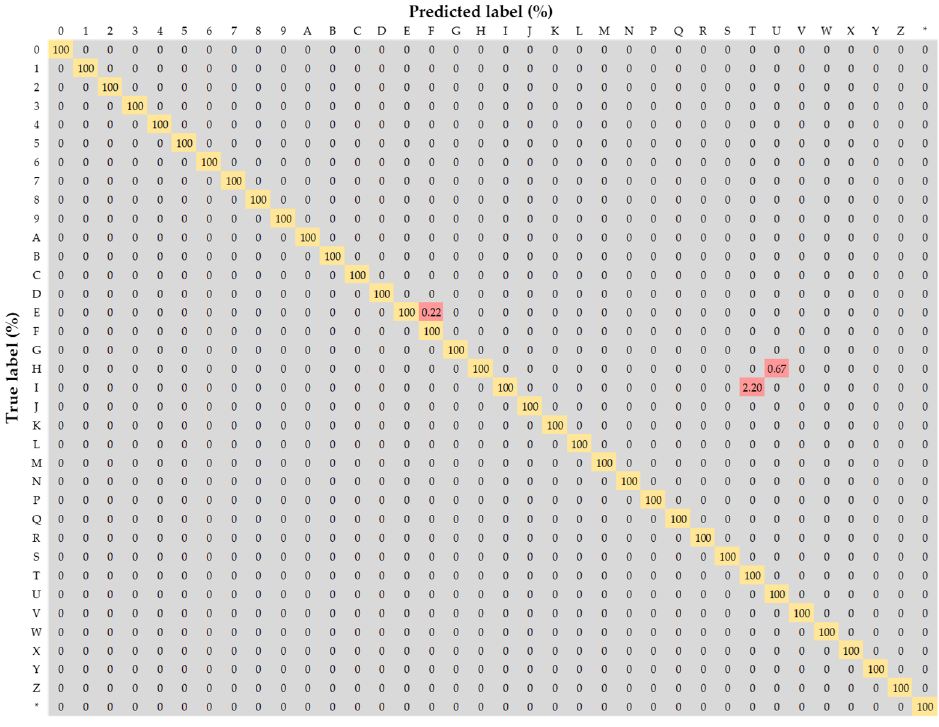
Figure 11. Multi-currency (KRW, USD, INR, JPY) confusion matrix for the test dataset. Table 5. Comparison of banknote serial number recognition methods.